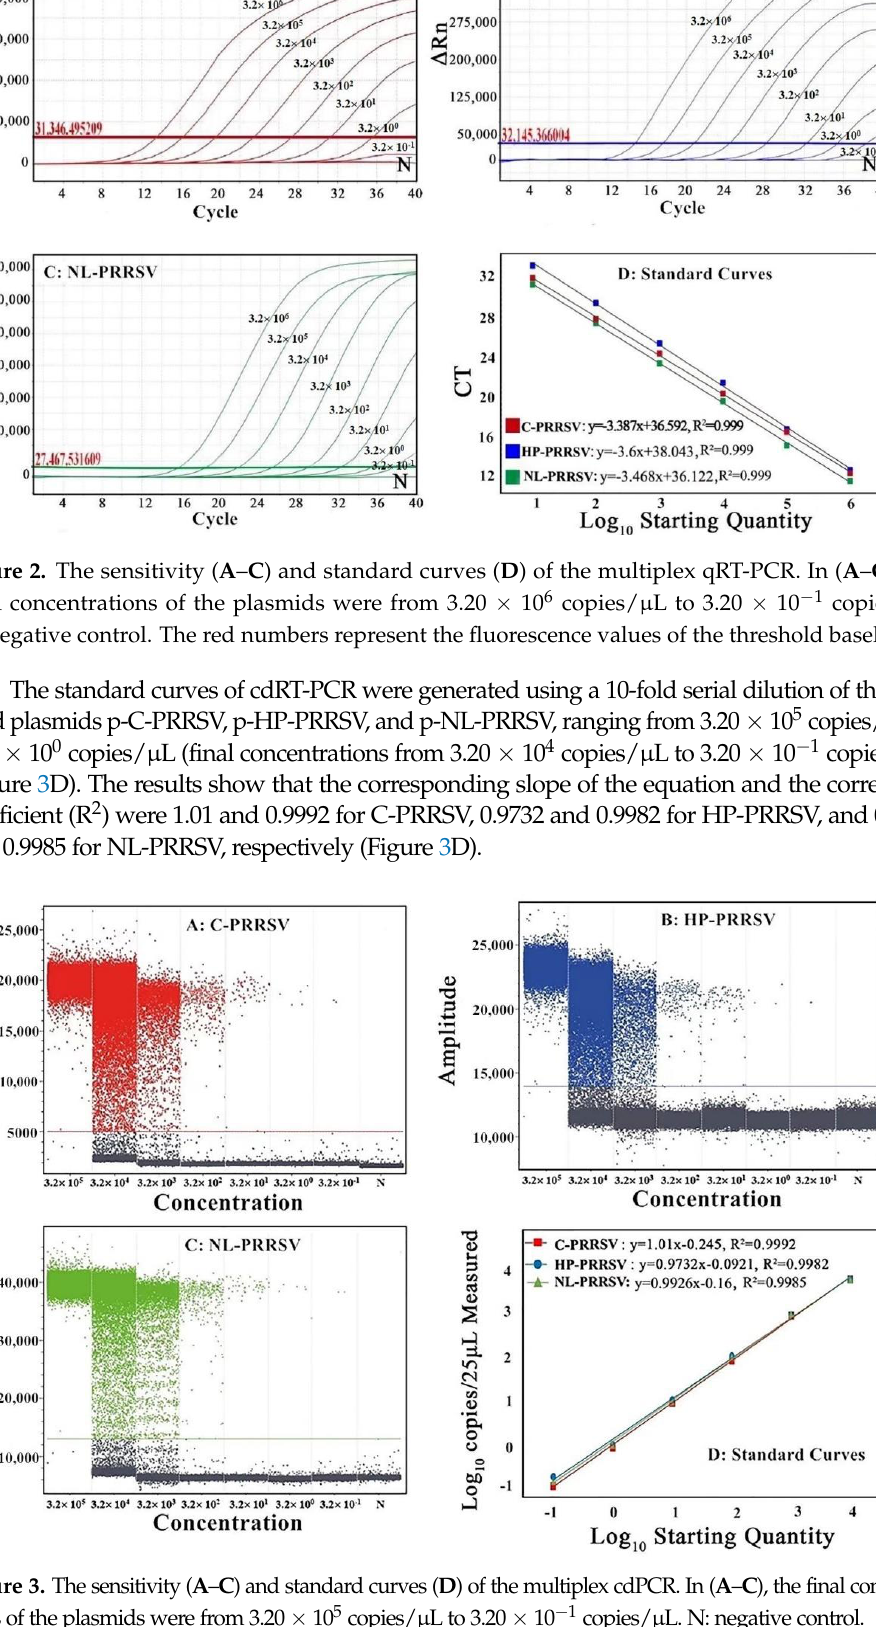
Figure 3. The sensitivity ( A – C ) and standard curves ( D ) of the multiplex cdPCR. In ( A – C ), the final concentrations of the plasmids were from 3.20 × 10 5 copies/μL to 3.20 × 10 −1 copies/μL. N: negative control.